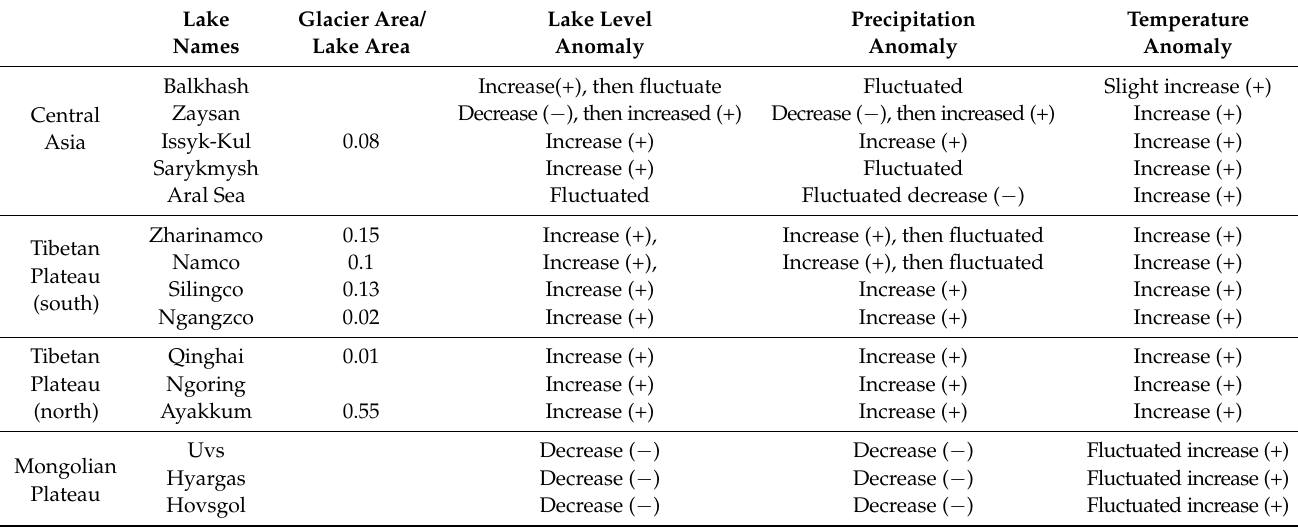
Table 3. The summary of trends of lake level anomaly, precipitation anomaly and temperature anomaly in the lake over CA, TP, and